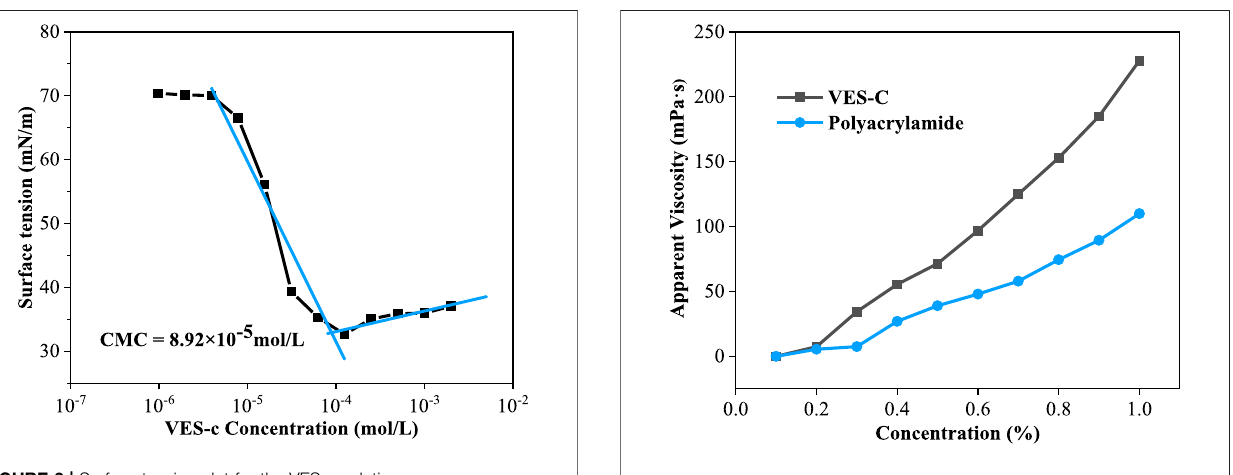
FIGURE 3 | Surface tension plot for the VES-c solution. FIGURE 4 | The comparison of viscosities between the VES-c and